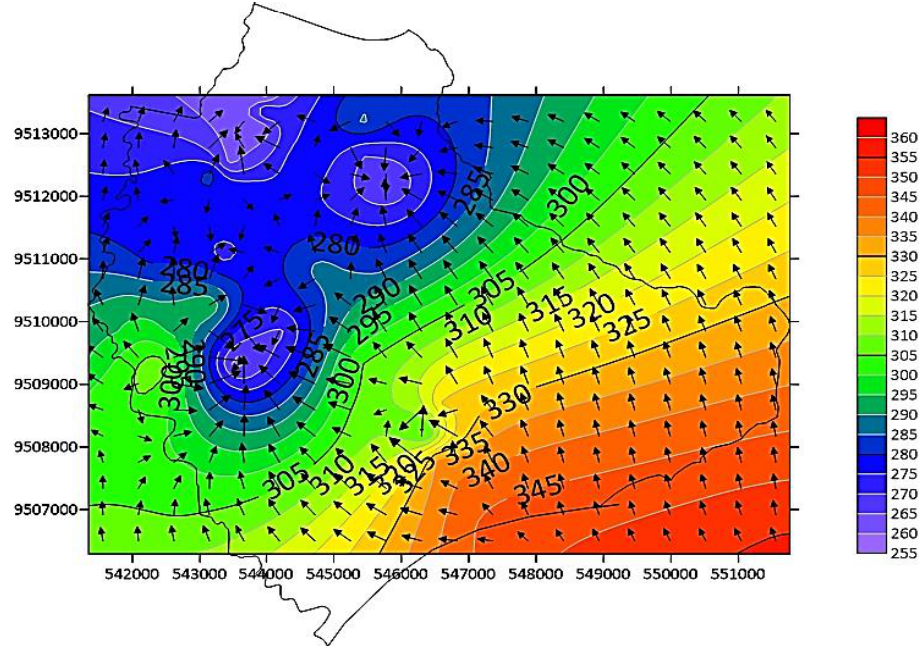
Figure 22. Groundwater production map.